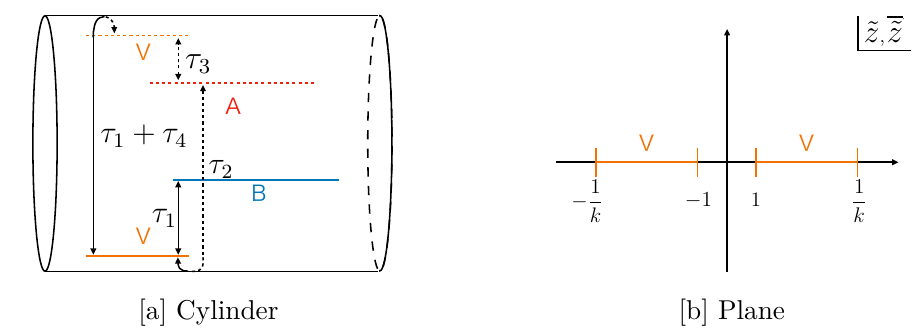
Figure 1 . Left panel : a cartoon of the thermal cylinder with two cuts. In this figure, the red and blue lines correspond to the subsystems A and B respectively. The orange lines illustrate the cuts corresponding to the projective measurement. Right panel : a cartoon of the projective measurement on the plane. In this panel, we only show the location of the projective measurement. The parameter k is defined by